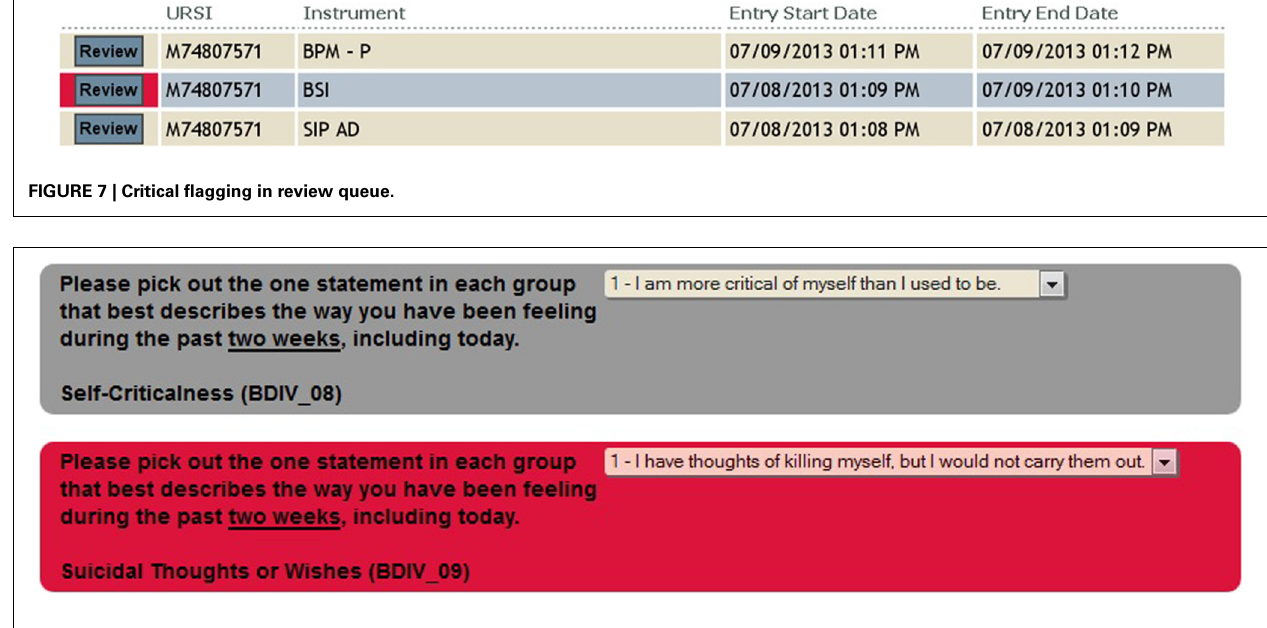
FIGURE 8 | Critical flagged